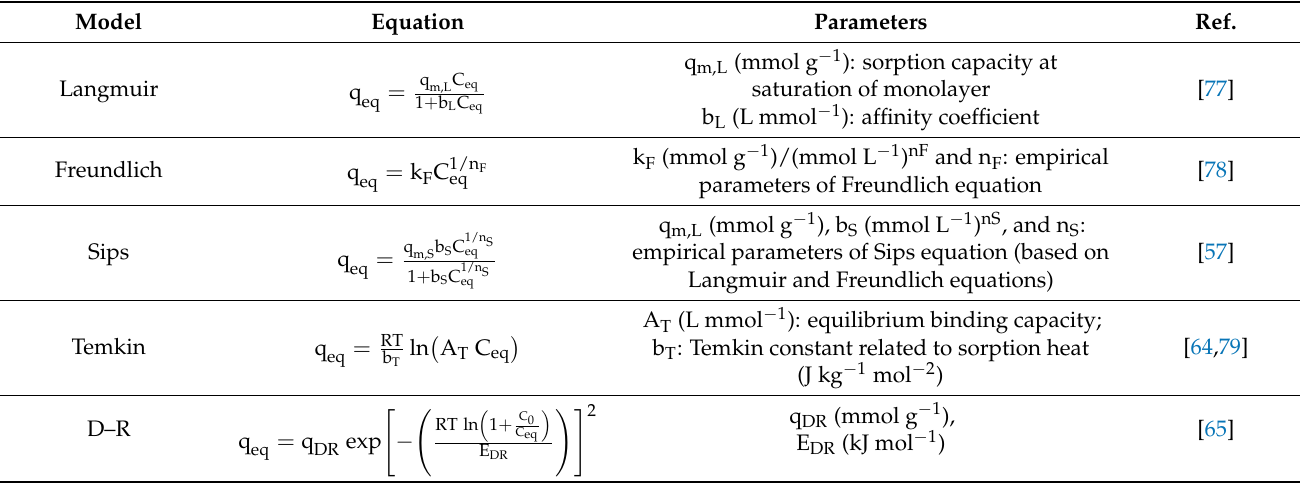
Table A3. Equations used for modeling sorption isotherms.